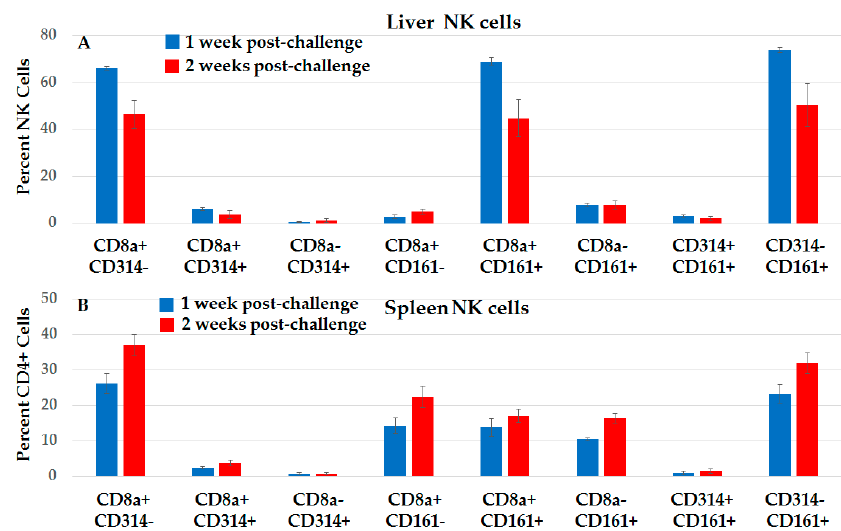
Figure 11. Liver and spleen NK cell subset phenotypic analysis post-challenge shows a vaccine-like effect. Lymphocytes were isolated from liver ( A ) and spleen ( B ) at 1 and 2 weeks post challenge and then stained with CD56, CD3, CD8a, CD314 (NKG2D) and CD161. Analysis done on CD56+/CD3 − cells. n = 3; error bars = SEM.